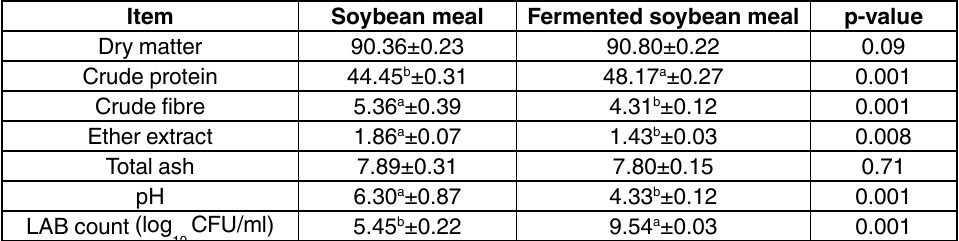
Table 1. Chemical composition of soybean meal on DM basis before and after fermentation, per cent